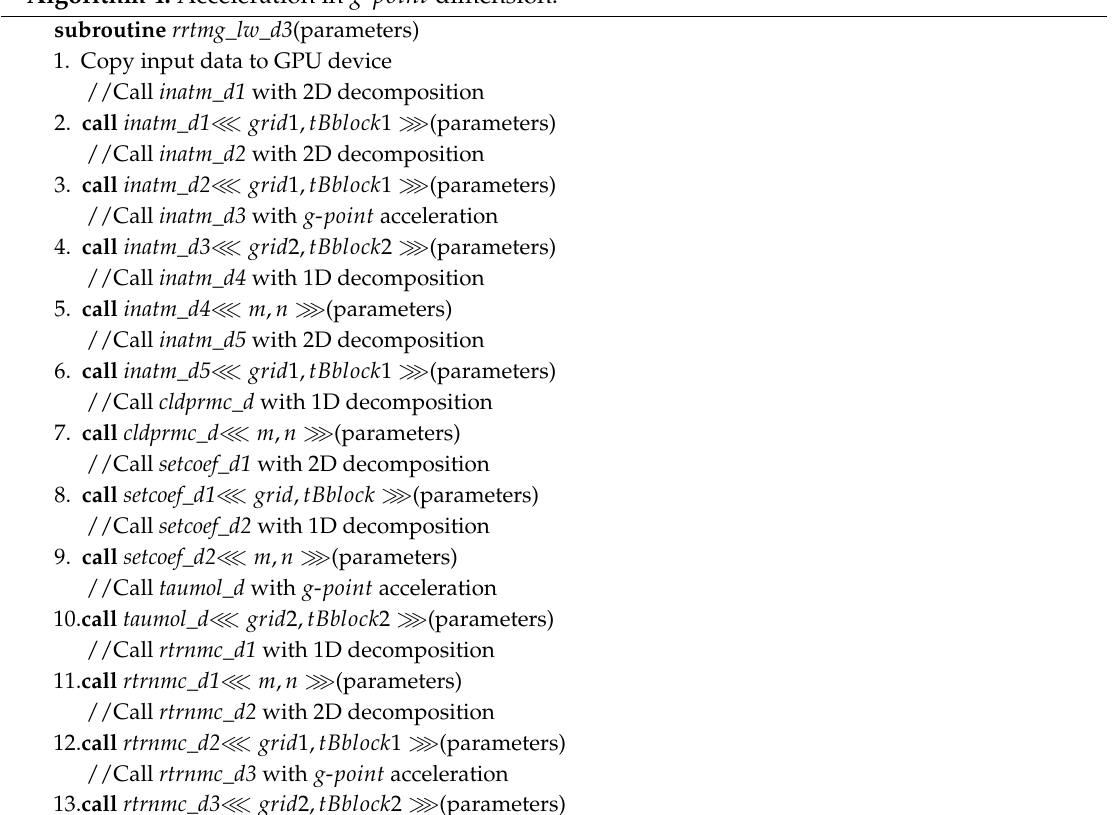
Algorithm 4: Acceleration in g - point